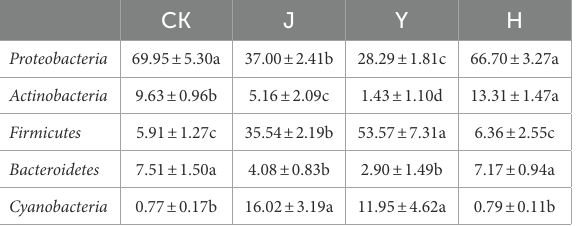
TABLE 10 Comparison of major bacterial community composition of soybean-potted rhizosphere soil at the phylum level. CK J